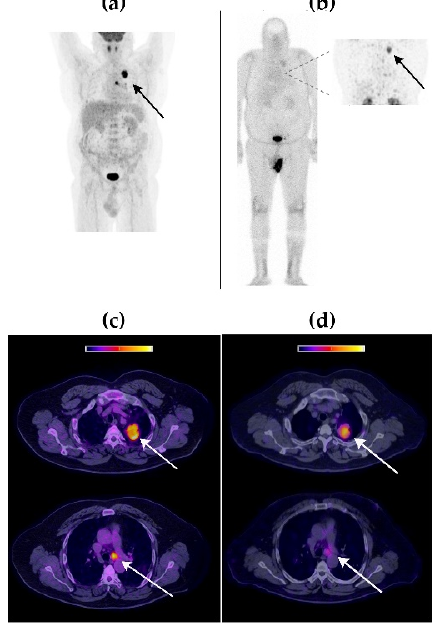
Figure 4. Patient with left lung adenocarcinoma (Patient 2). ( a ) Maximum-intensity projection [ 18 F]FDG PET image at 1 h p.i. ( b ) [ 99m Tc]Tc-iFAP whole-body planar scintigraphy in anterior projection. Inset: thoracic SPECT at 3 h p.i. ( c ) [ 18 F]FDG PET/CT axial sections. ( d ) [ 99m Tc]Tc-iFAP SPECT/CT axial sections. Solid lesion in the apicoposterior segment of the left upper lobe with irregular edges, which contacts the mediastinal pleura. Mediastinal adenopathy at subaortic level 5. The uptake of both radiopharmaceuticals was concordant in all tumor lesions. Table 4. Tumor/background (T/B) ratios evaluated with the [ 99m Tc]Tc-iFAP and [ 18 F]FDG radiotrac- ers in cancer patients. Primary